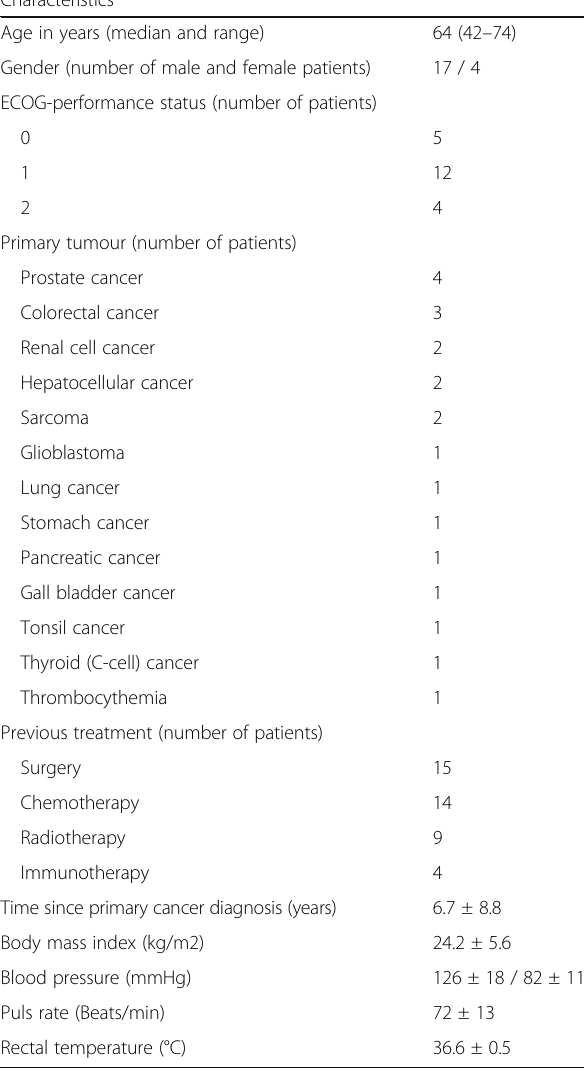
Table 1 Patient characteristics Characteristics